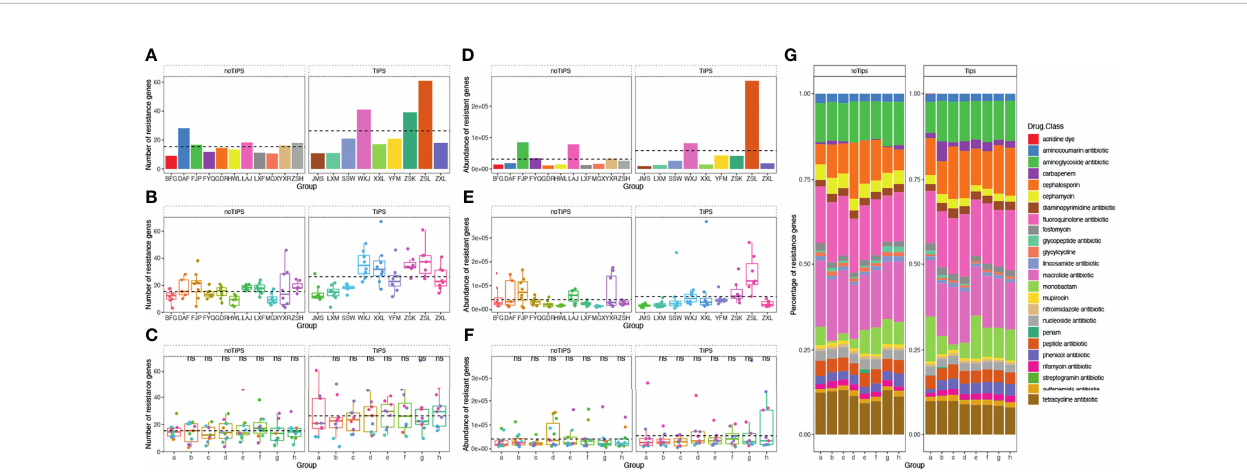
FIGURE 7 | Number, abundance, and composition of drug resistance genes in the gut microbiome of TIPS and non-TIPS patients. (A) Comparison of the number of gut resistance genes per patient in the TIPS group and non-TIPS group before rifaximin administration. (B) Comparison of the number of gut resistance genes in the TIPS group and the non-TIPS group during rifaximin administration (seven samples per patient). (C) The change in the number of gut resistance genes in the TIPs group and the non-TIPS group during rifaximin administration. (D) Change in the number of gut resistance genes in the TIPs group and the non-TIPS group before rifaximin administration. (E) Comparison of the abundance of gut resistance genes in the TIPS group and the non-TIPS group during rifaximin administration (seven samples per patient). (F) The change in the abundance of gut resistance genes in the TIPs group and the non-TIPS group during rifaximin administration. (G) Composition of drug resistance genes in the gut microbiome of TIPS and non-TIPS patients. The dashed line in the graphs represents the mean. ns denotes no statistical difference compared with samples collected before drug